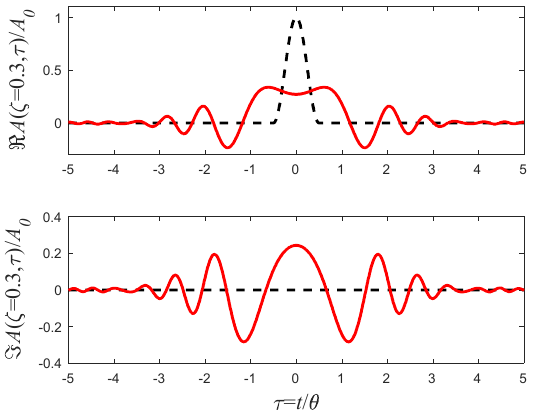
represents three levels of singularities. Equation (27) represents a case of amplitude discontinuity, Equation (39) represents discontinuity in the pulse’s amplitude’s derivative, and Equation (42) represents discontinuity in the amplitude's second derivative. As can clearly be seen, the higher is the level of the singularity (i.e., the discontinuity occurs at higher derivatives), the faster the pulse decays in accordance with Ref. [22,23].